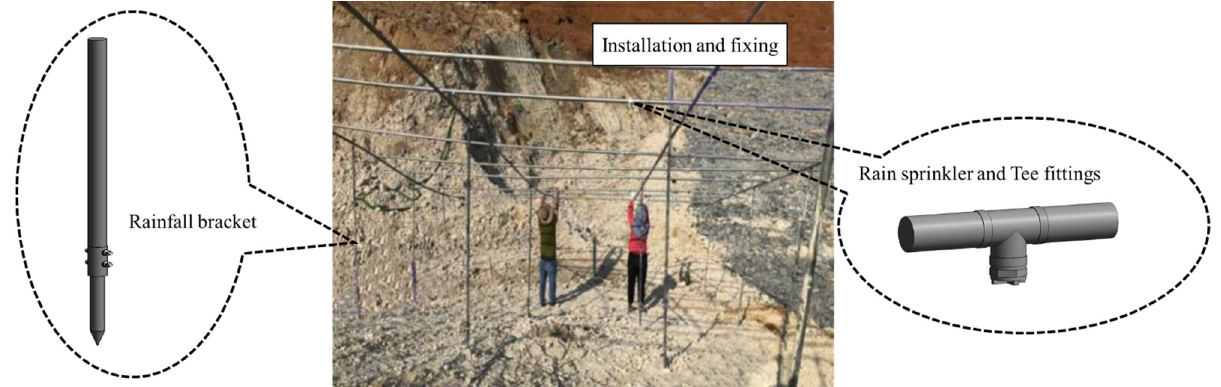
Figure 6. Site installation of the rainfall system.